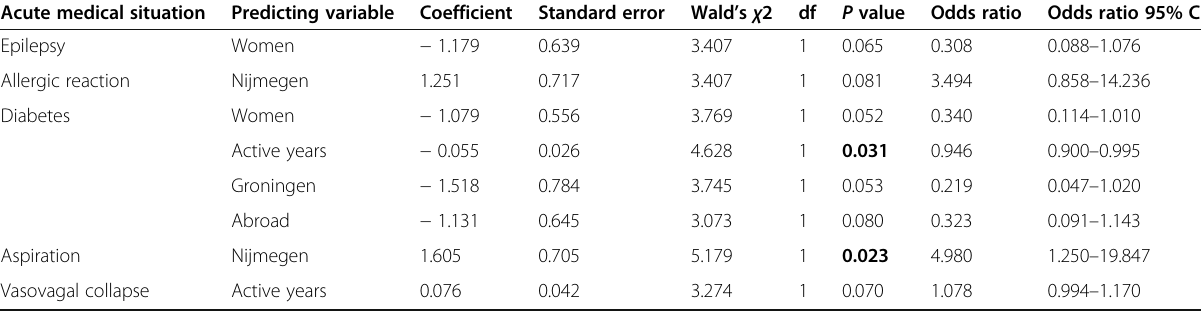
Table 3 Multiple logistic regression analysis was performed for all acute medical situations and the following predicting variables: sex, years clinically active, and training